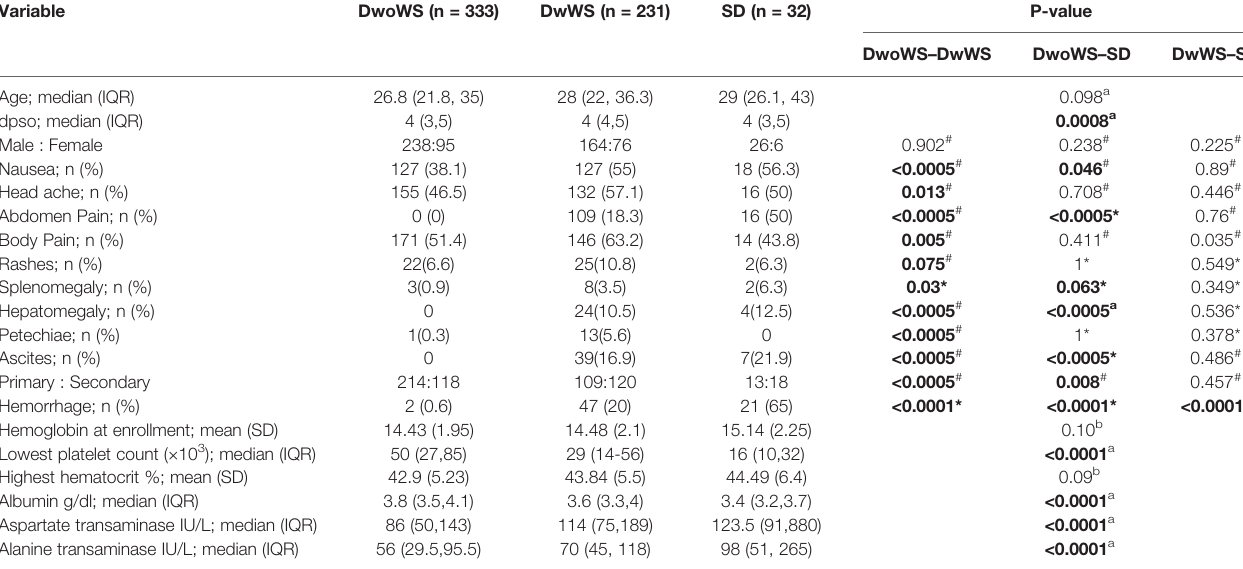
TABLE 1 | Demographic characteristics, clinical symptoms, and laboratory parameters of dengue patients.